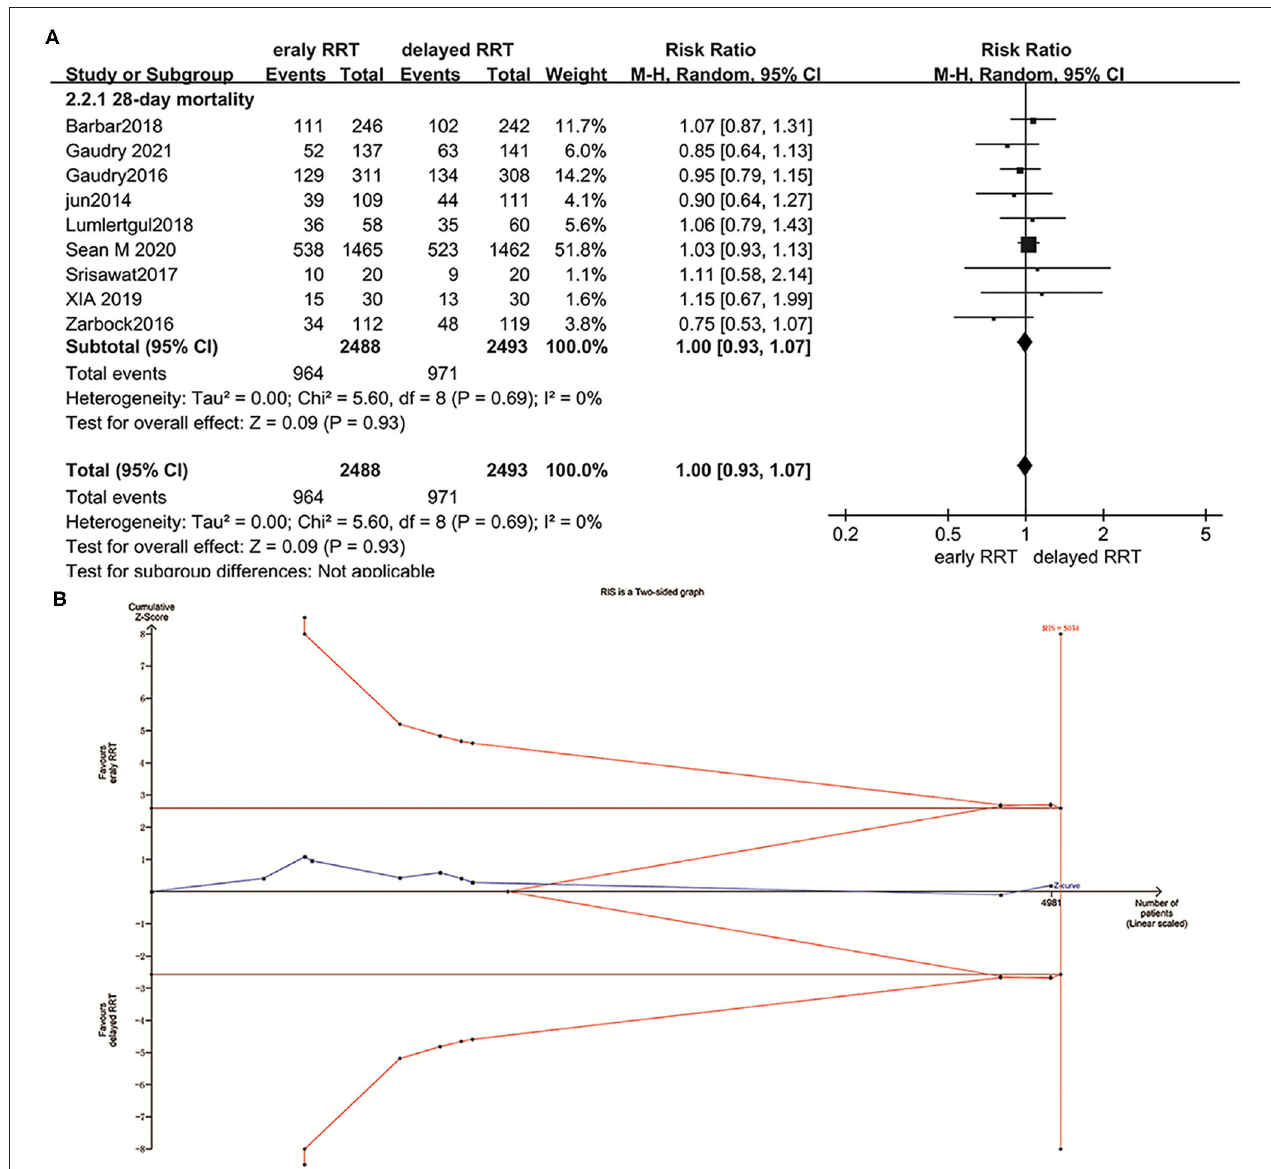
FIGURE 3 | Forest plot for all-cause mortality at day 28 (A) and trial sequential analysis (TSA) for all-cause mortality at day 28 (B) .